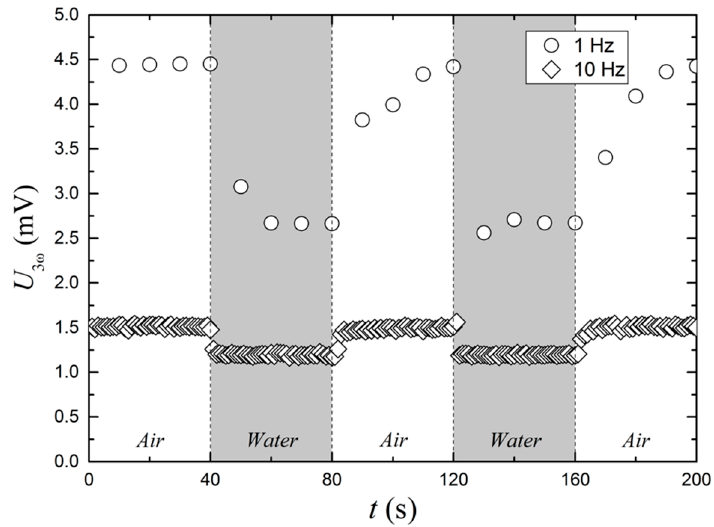
Figure 12 . The graph shows the sensors response to alternately being surrounded by air and water. Two different datasets with different driving frequencies are presented. The temperature of the water and the air is the